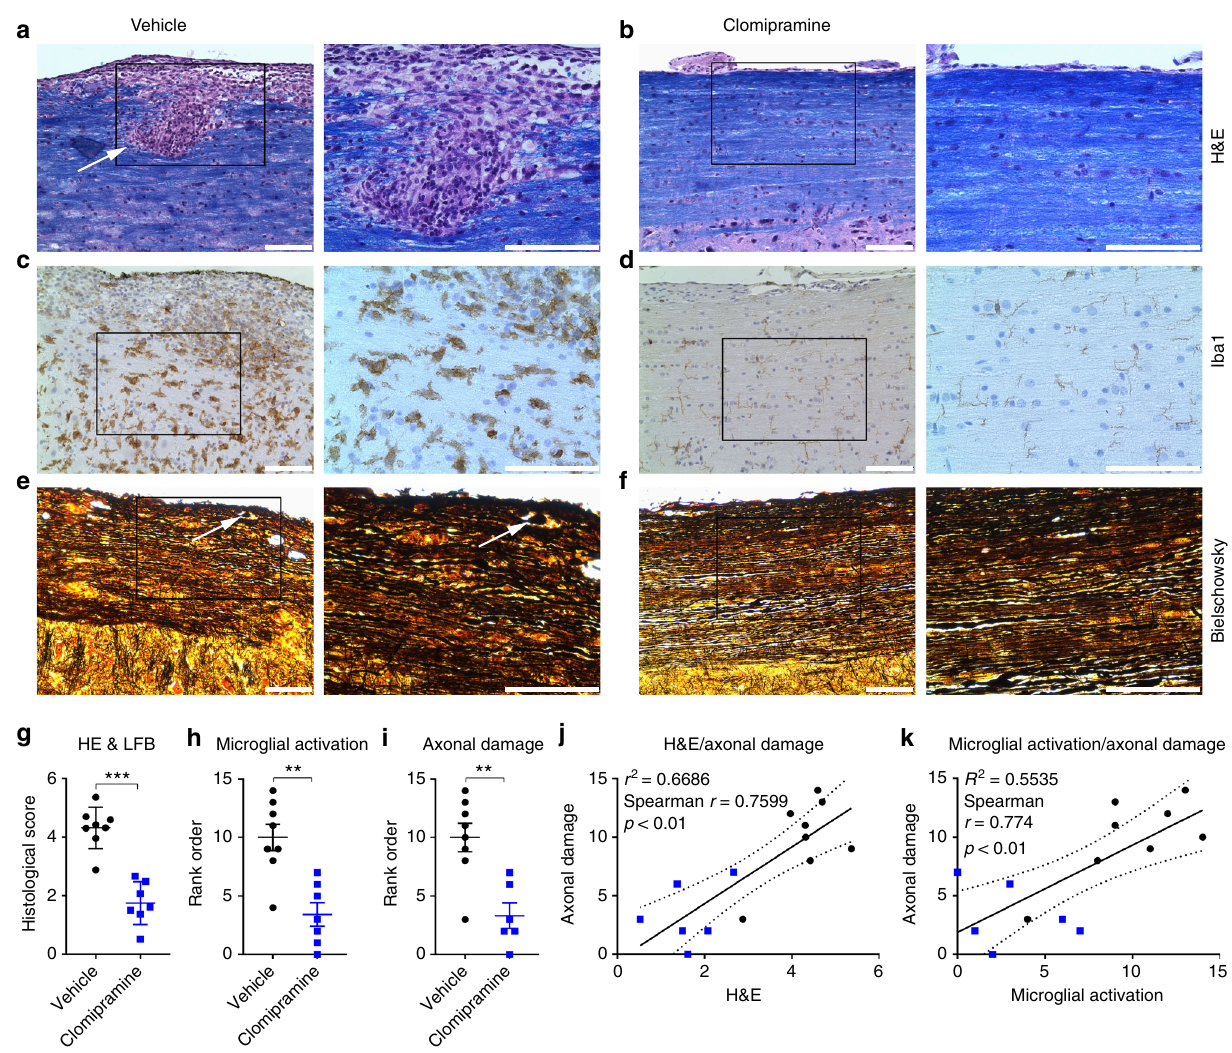
Fig. 9 Reduced in fl ammation and axonal damage upon clomipramine treatment. Vehicle-treated animals had marked parenchymal in fl ammation, indicated by an arrow ( a ), whereas clomipramine-treated animals only had low meningeal in fl ammation ( b ). This was re fl ected in better histological scores ( g ) evaluated by a previously described method 54 ( a , b : Hematoxylin/eosin and luxol fast blue, HE and LFB). Vehicle-treated animals had pronounced microglial activation (Iba1 stain, c ), which was accompanied by axonal damage with formation of axonal bulbs (indicated by an arrow, Bielschowsky stain, e ). Clomipramine treatment reduced microglial activation concomitant with preserved axonal integrity ( d , f ). This was re fl ected in a blinded rank order analysis ( h , i ). In fi ltration and microglial activation positively correlated with axonal damage ( j , k ). c / e and d / f are adjacent sections. Images are shown in 20-times and 40-times original magni fi cation. The scale bars show 100 µ m. Non-parametric two-tailed Mann – Whitney test ( g – i ) and non- parametric two-tailed Spearman correlation with 95% con fi dence interval ( j , k ). Signi fi cance is shown as ** p < 0.01; *** p <